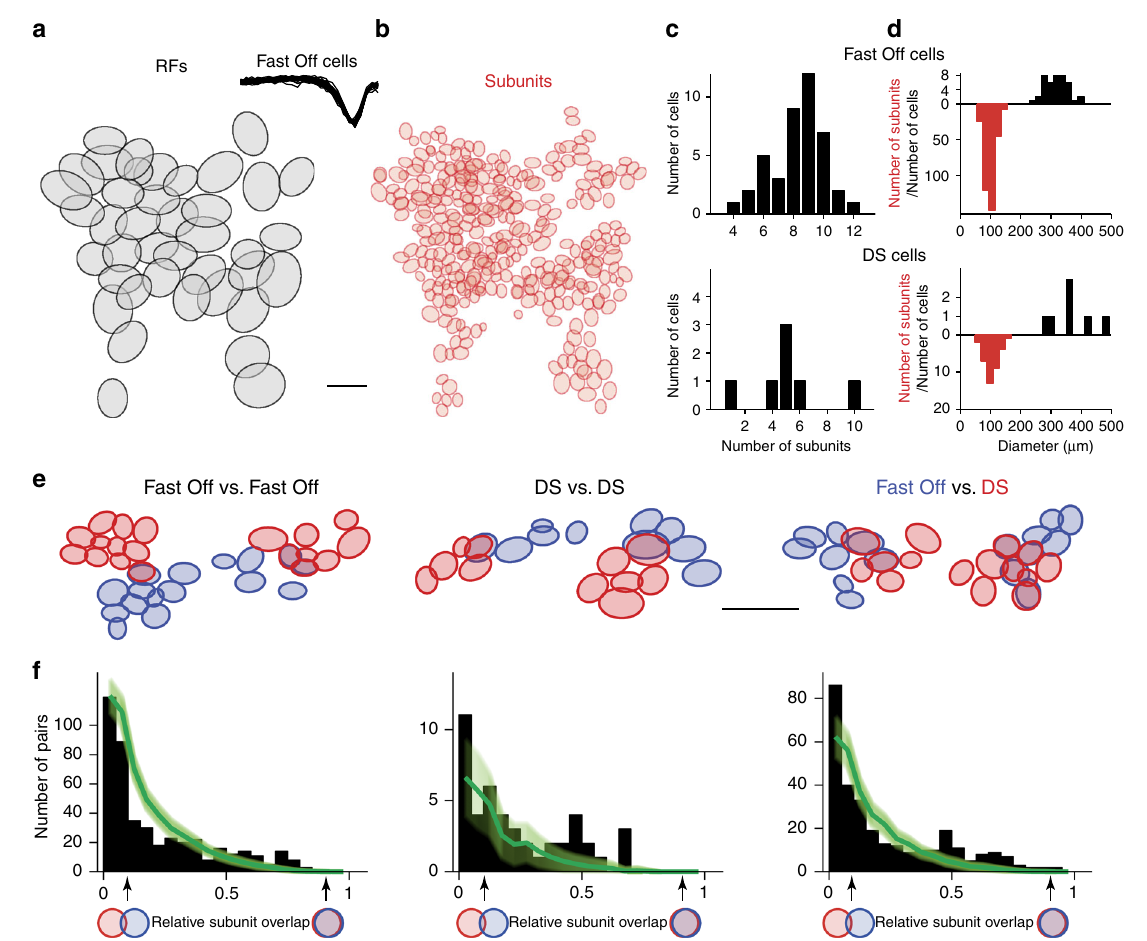
Fig. 5 Analyzing subunit overlap for ganglion cell populations. a Layout of receptive fi elds of fast Off ganglion cells from a single recording. Scale bar, 300 µ m. Inset shows the collection of temporal fi lters (670 ms long) for the fast Off cells. b Layout of reconstructed subunits for the collection of cells shown in a . c Histograms of the numbers of subunits per cell for fast Off and direction-selective (DS) ganglion cells from the experiment shown in a . d Histograms of the diameters of receptive fi elds ( black ) and subunits ( red ). e Examples and distributions of overlapping subunits among fast Off cells ( left ), DS cells ( center ), and pairs of fast Off and DS cells ( right ). Scale bar, 300 µ m. f Distributions of relative overlap for pairs of subunits from different ganglion cell classes ( black bars ), collected from fi ve retinas (110 fast Off cells, 40 DS cells). Subunit pairs with zero overlap were excluded. For comparison, distributions of chance overlaps, obtained by shuf fl ing the receptive fi eld center positions within each ganglion cell class, are shown in green ( shaded region corresponding to one standard deviation, obtained from repeated shuf fl ing). All actual overlap distributions show an excess of well matching subunits (relative overlap larger than about 0.5) as compared to chance, indicating that ganglion cells within as well as across the two ganglion cell classes